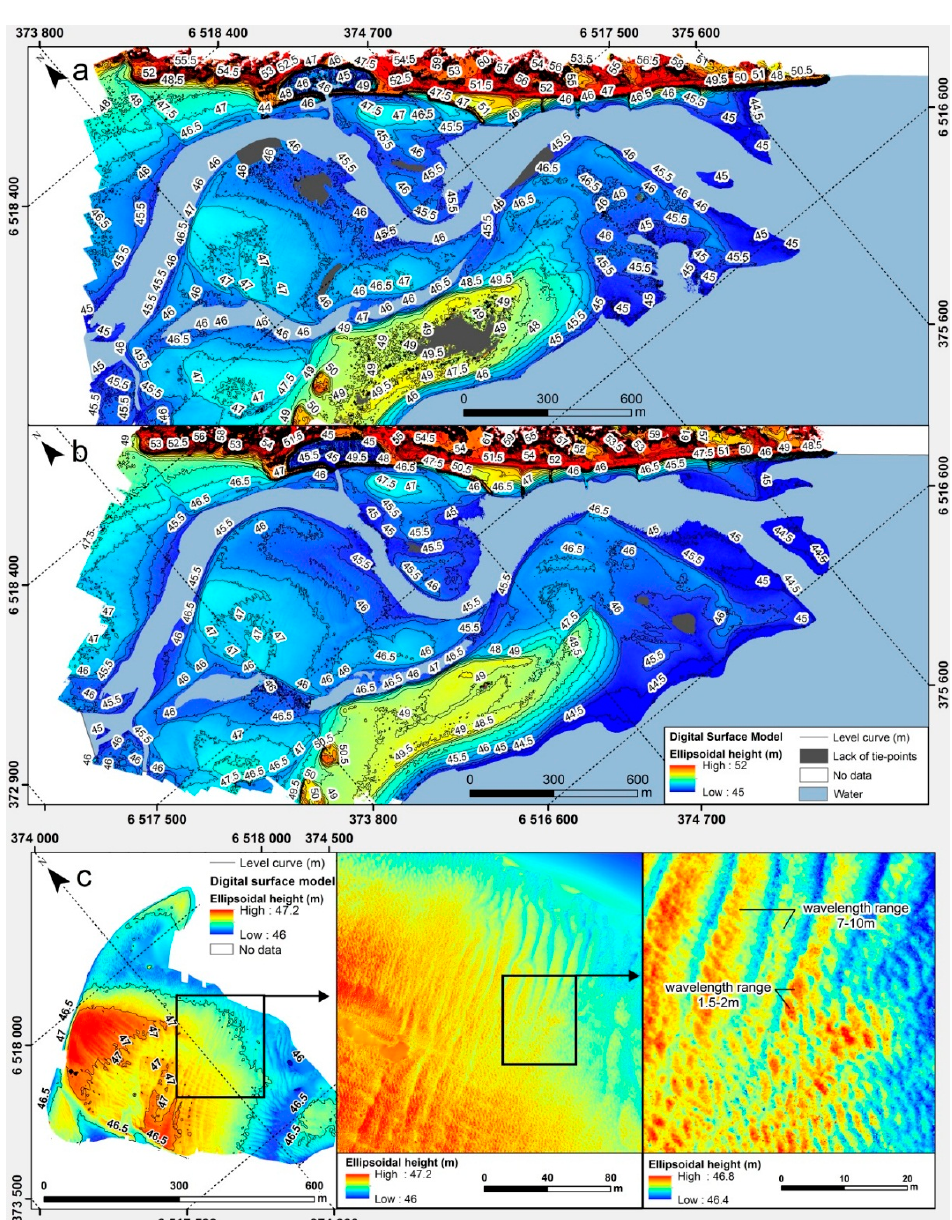
Figure 8. DSMs obtained from the three campaigns: ( a ) campaign 1; ( b ) campaign 2; and ( c ) campaign 3. The spatial resolutions are 20 cm for ( a ) and ( b ) and 2 cm for ( c ). Isolines computed over 5-m-resolution DSMs were superimposed every 0.5 m to improve the representation of the morphology on figures a – c . Grey areas correspond to lack of tie points. White areas correspond to no data (inside the sand banks).